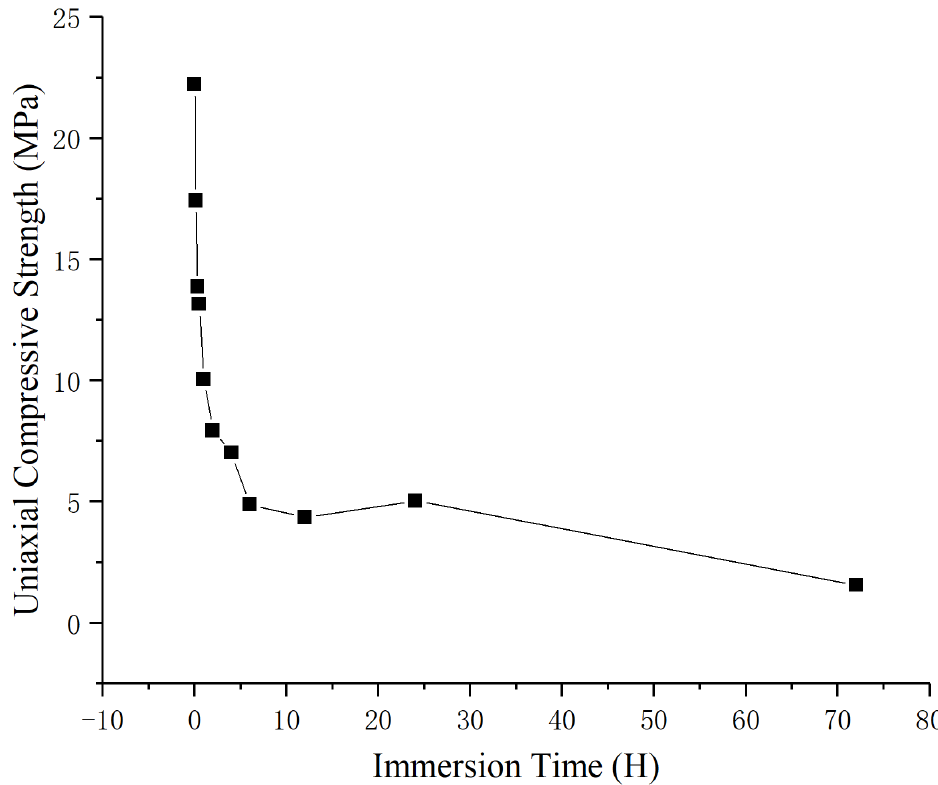
Figure 4. The relation of uniaxial compressive strength and immersion